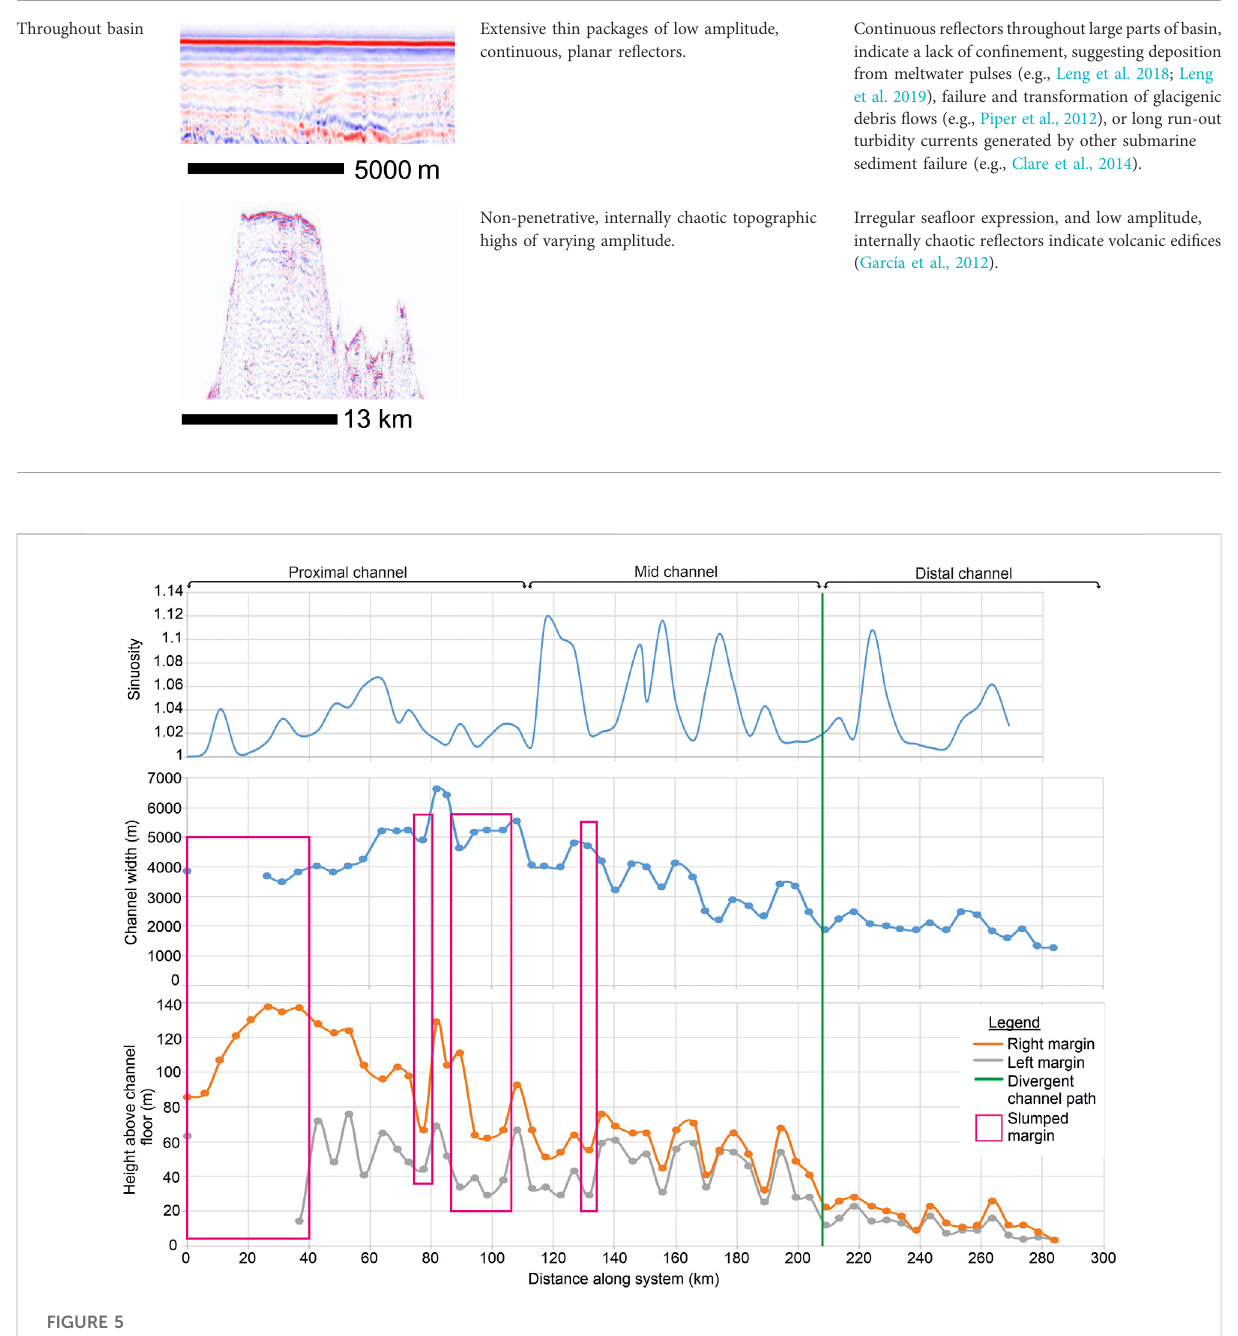
FIGURE 5 Comparison ofsinuosity,channelwidth, channelmargin height ( ‘ rightand leftmargin ’ inlegend), gradient,thalweg depthand pro fi le symmetry for C3. The divergence of the channel path is represented by a green line. Right and left channel margin with respect to fl ow direction. ‘ Slumped margin ’ refers to slumping of the channel